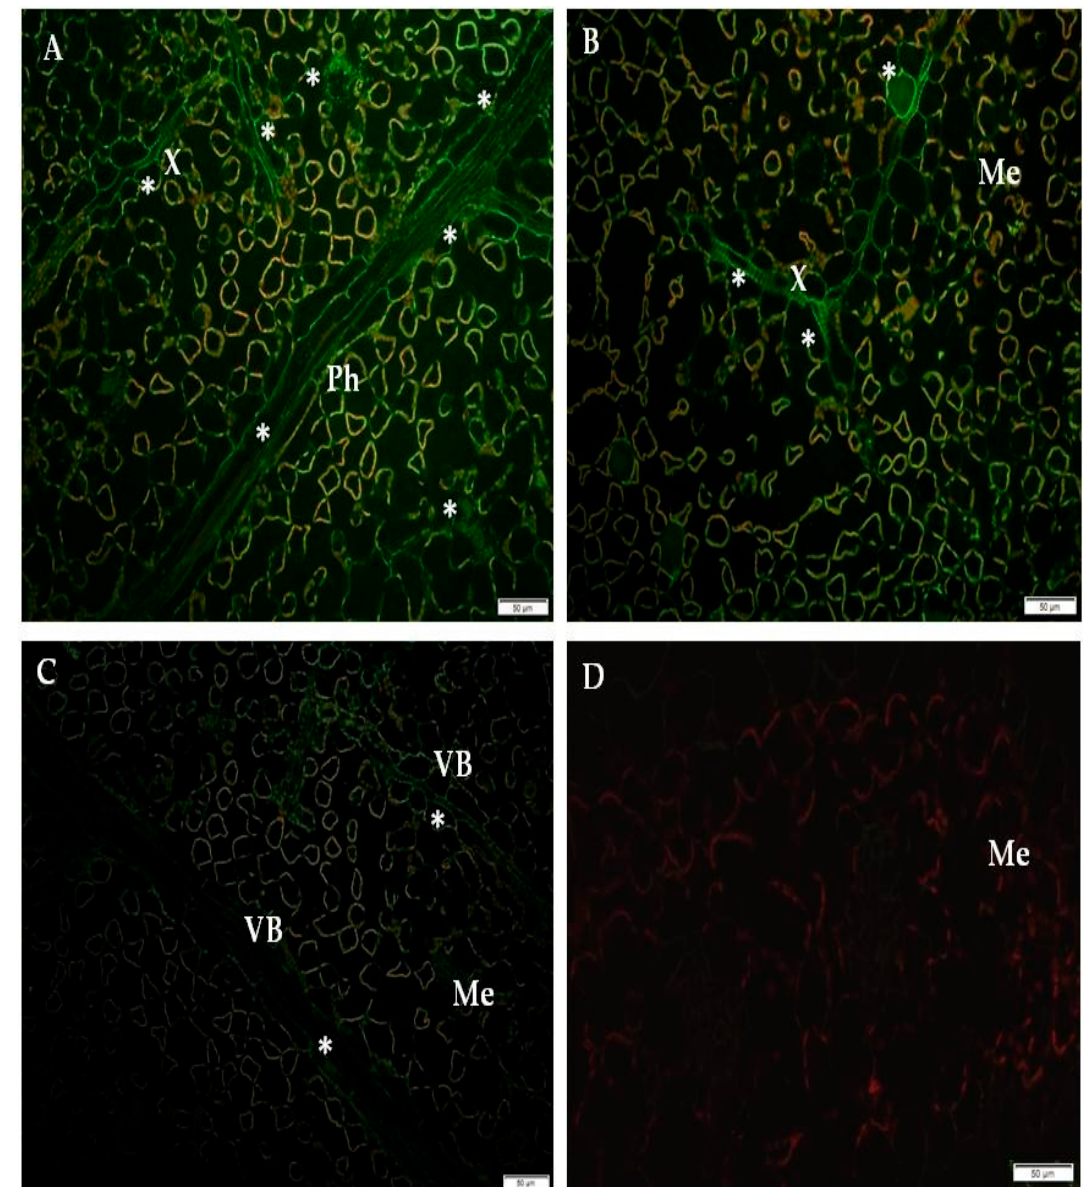
Figure 2. Immunofluorescence of RbohD protein localization in an incompatible interaction of potato Rywal plants with PVY NTN . ( A ) Signal of RbohD (*) in phloem and xylem cells 1 day after PVY NTN -inoculation. ( B ) RbohD signal (*) in xylem tracheary elements and a single necrotizing mesophyll cell. ( C ) RbohD signal (*) in the vascular bundle of mock-inoculated potato Rywal. ( D ) Control-lack of green fluorescence signal in hypersensitive response potato Rywal when primary antibodies were omitted. Bar 50 µm. Me—mesophyll, Ph—phloem, X—xylem, VB—vascular bundle.